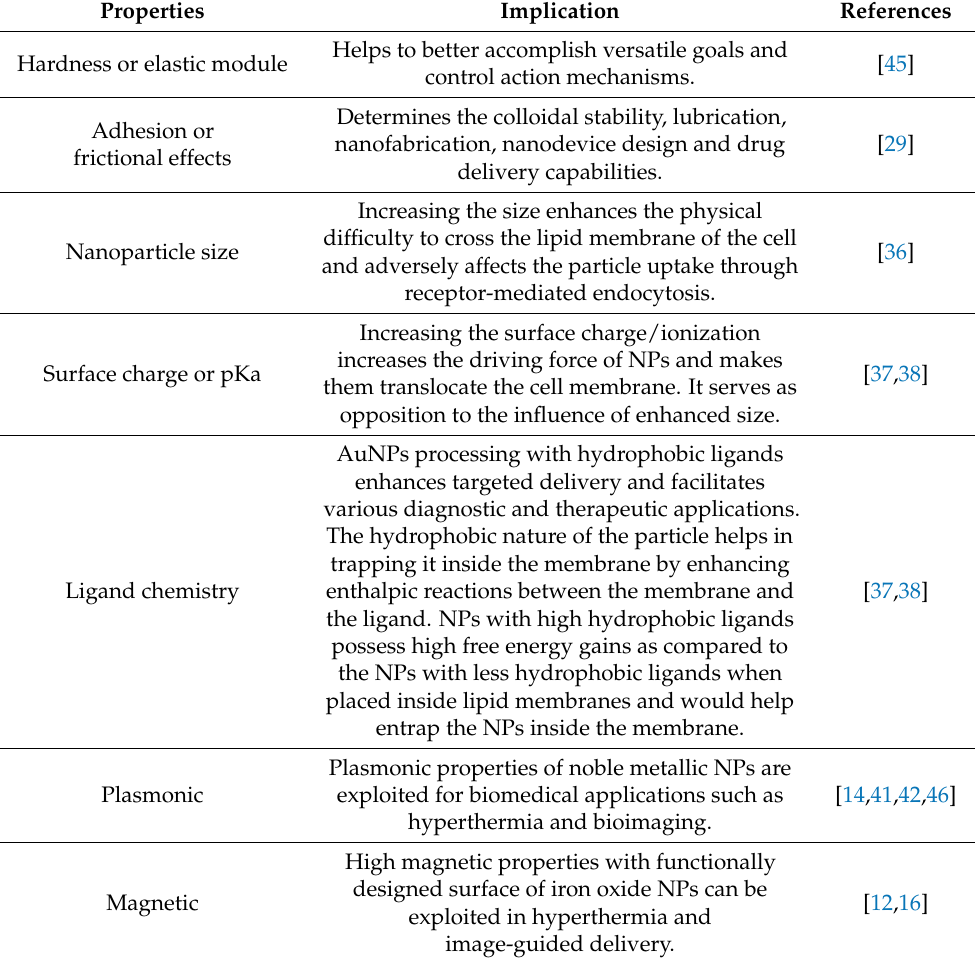
Table 1. A comprehensive list of properties and implications of nanoparticles.